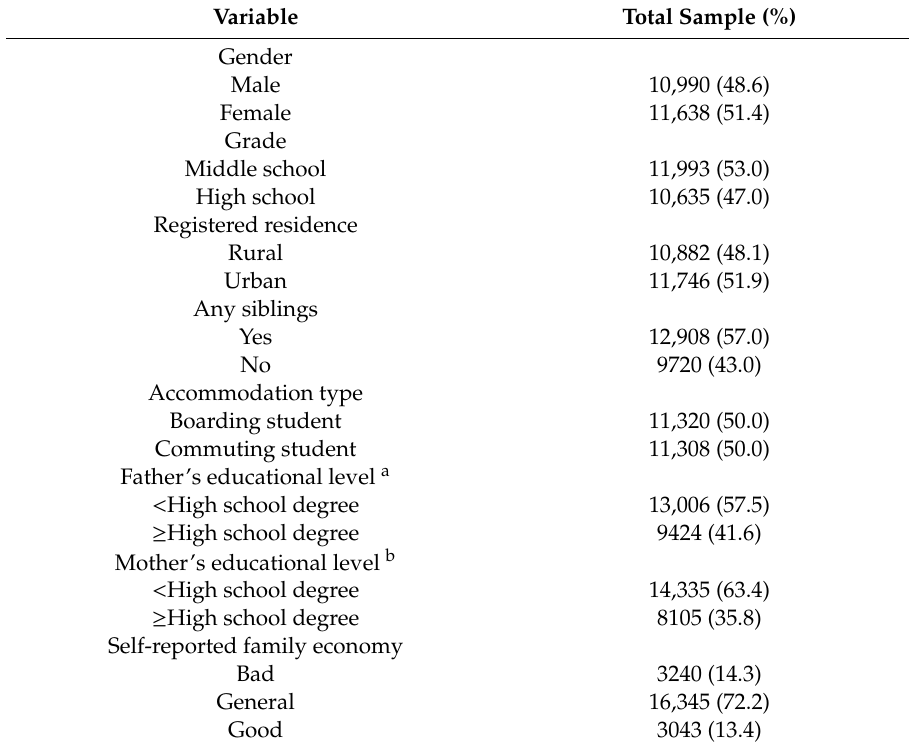
Table 1. Socio-demographic description of the